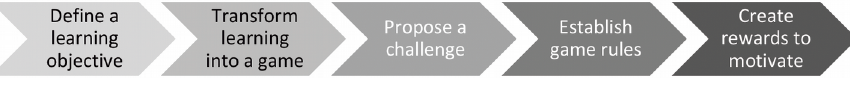
Figure 1. Gamification